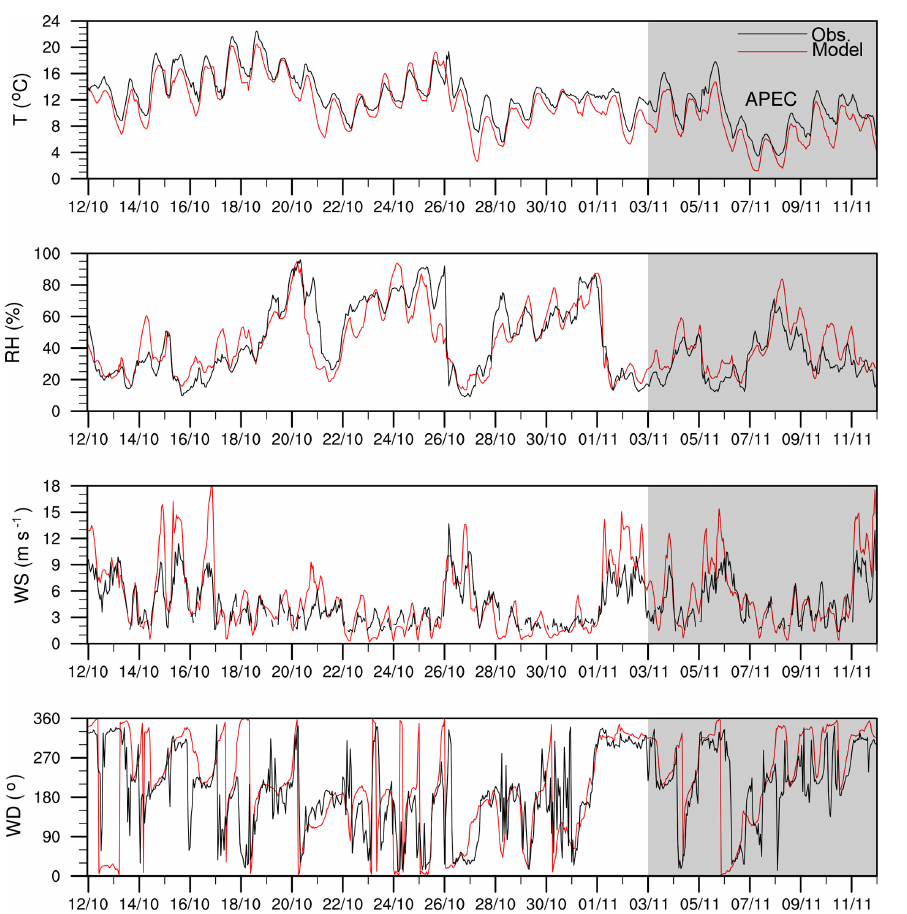
Figure 2. Comparison of meteorological measurements at 190–310m on IAP tower in Beijing with model simulations using ECMWF meteorological fields between 12 October and 12 November 2014. The period with emission controls is shaded.